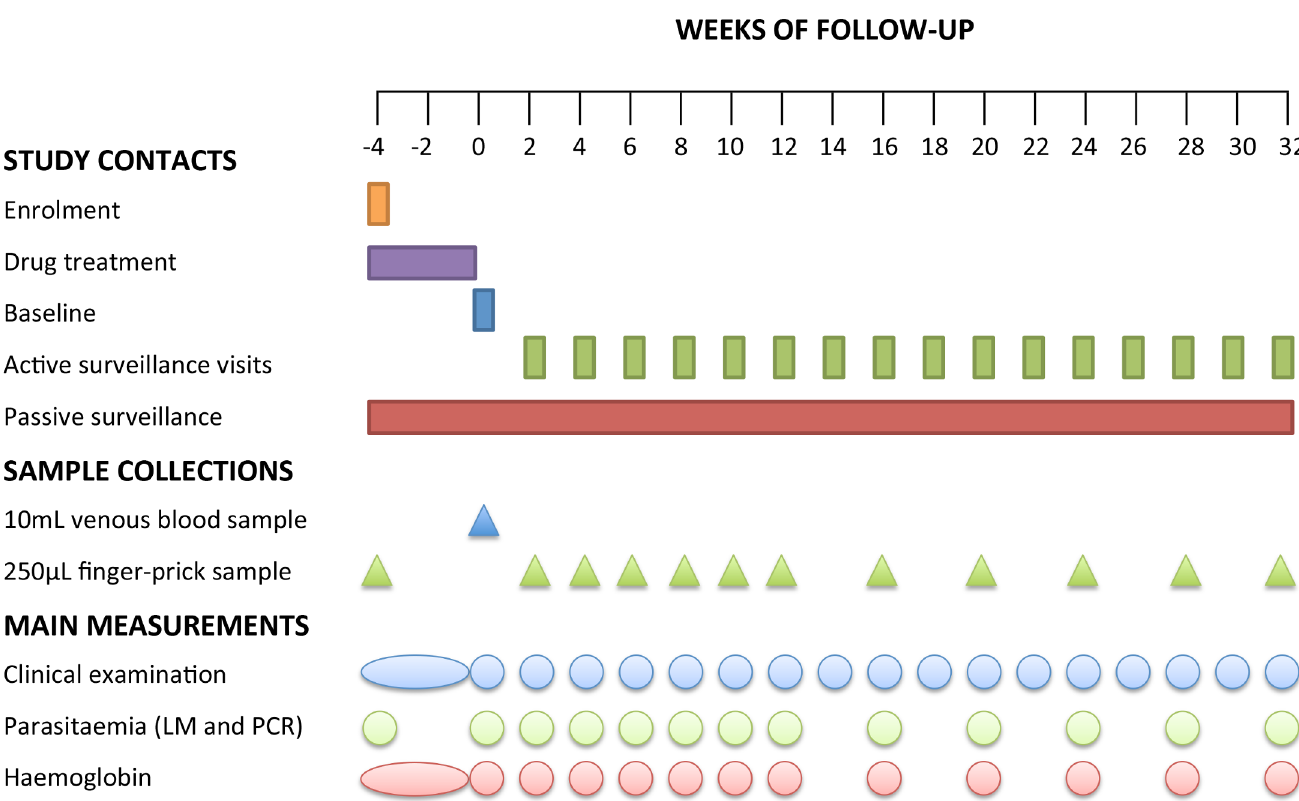
Fig 2. Study design and follow-up schedule. After the drug treatment period, children were actively monitored for infection and illness every 2 wk for the first 12 wk. From week 14 to 32, children were actively monitored for illness every 2 wk and for infection every 4